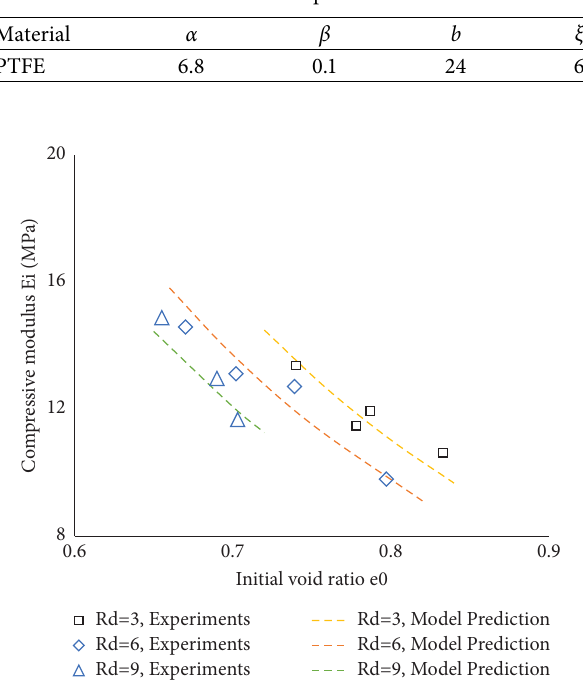
Figure 11: Te calculated E ( e , E i 0